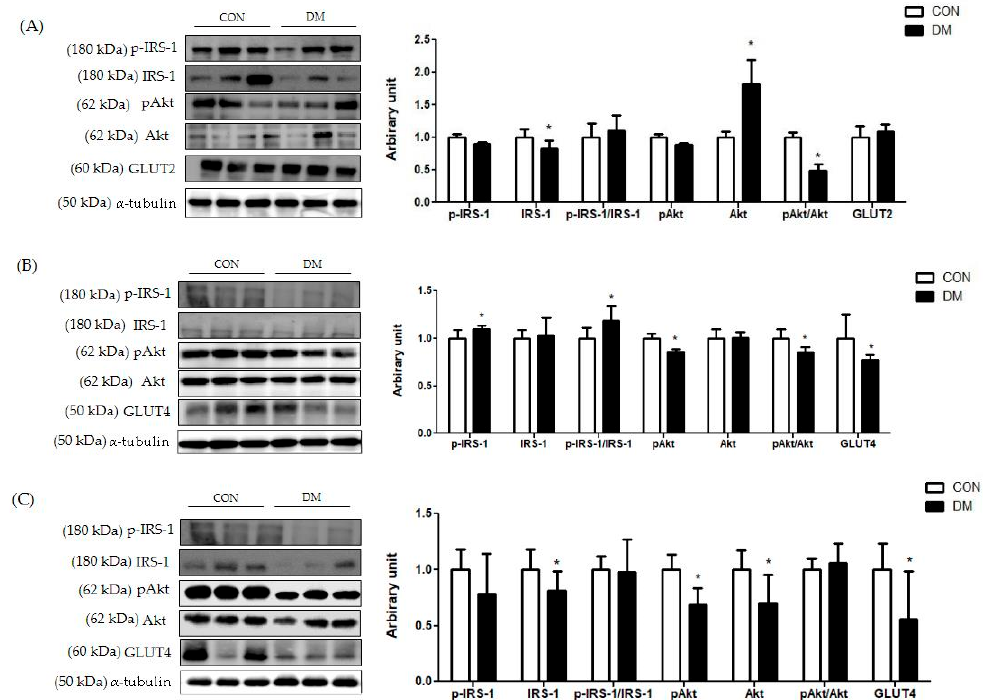
Figure 6. Insulin signaling in T2DM mice ( A ) liver, ( B ) skeletal muscle, and ( C ) hippocampus All values are reported as mean and SD. The asterisk represents statistical significance of differences from * p < 0.05. n = 9 mice in each group. CON, normal control mice; DM, diabetes mellitus mice.